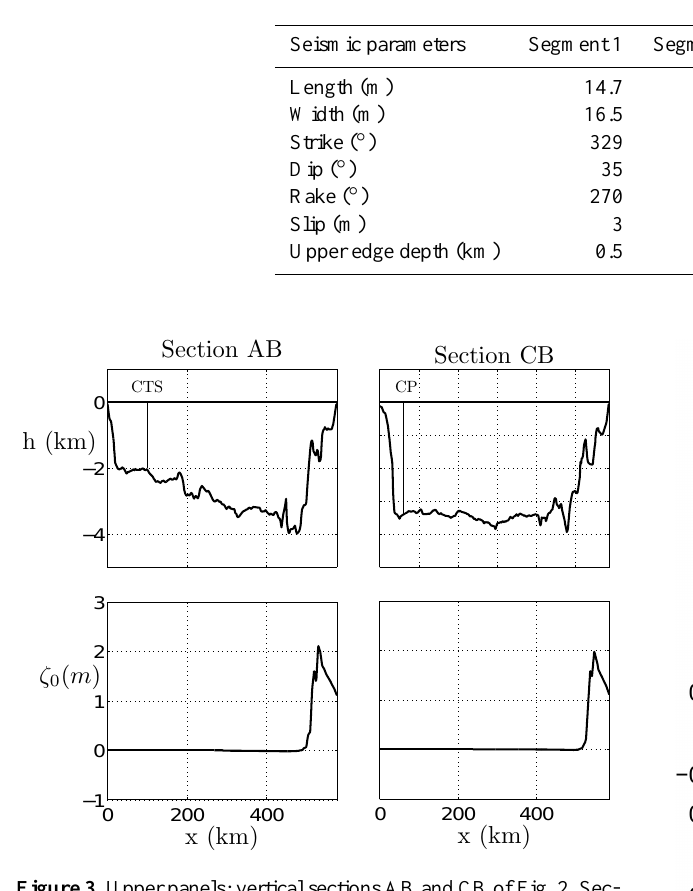
Table 3. Seismic parameters of the 1693 Sicily earthquake, as reconstructed by Tonini et al. (2011), for the four segments from north to south.